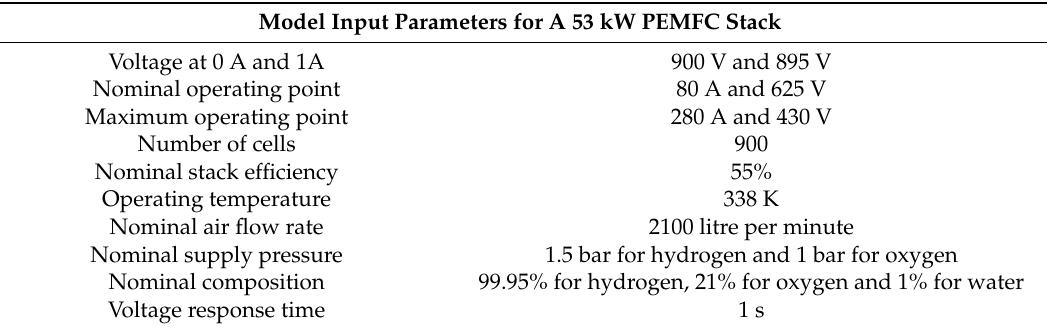
Table 1. Proton Exchange Membrane Fuel Cell (PEMFC) model parameters.